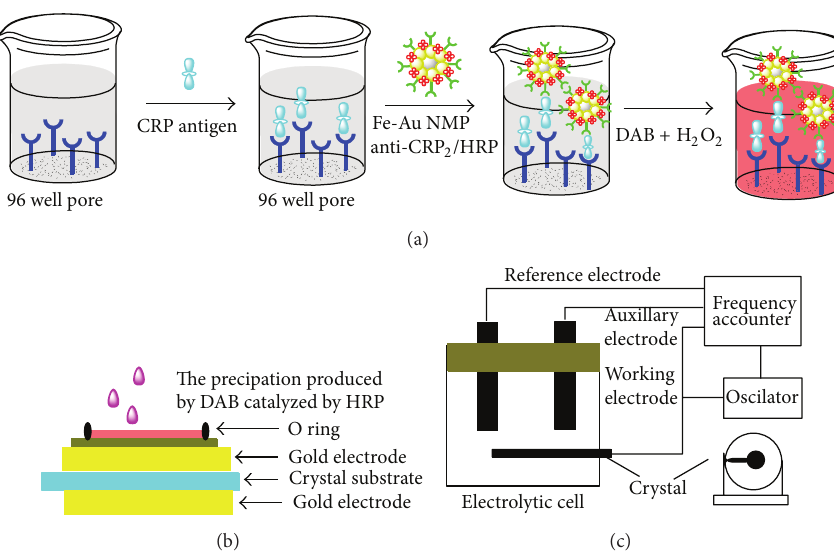
Figure 2: Schematic of the preparation of Fe-Au MNPs-anti-CRP2/HRP conjugation and the immunoassay procedure with the application of Fe-Au MNPs-anti-CRP2/HRP as the signal tag (a) and the EQCM’s measurement steps (b) and detection system (c).